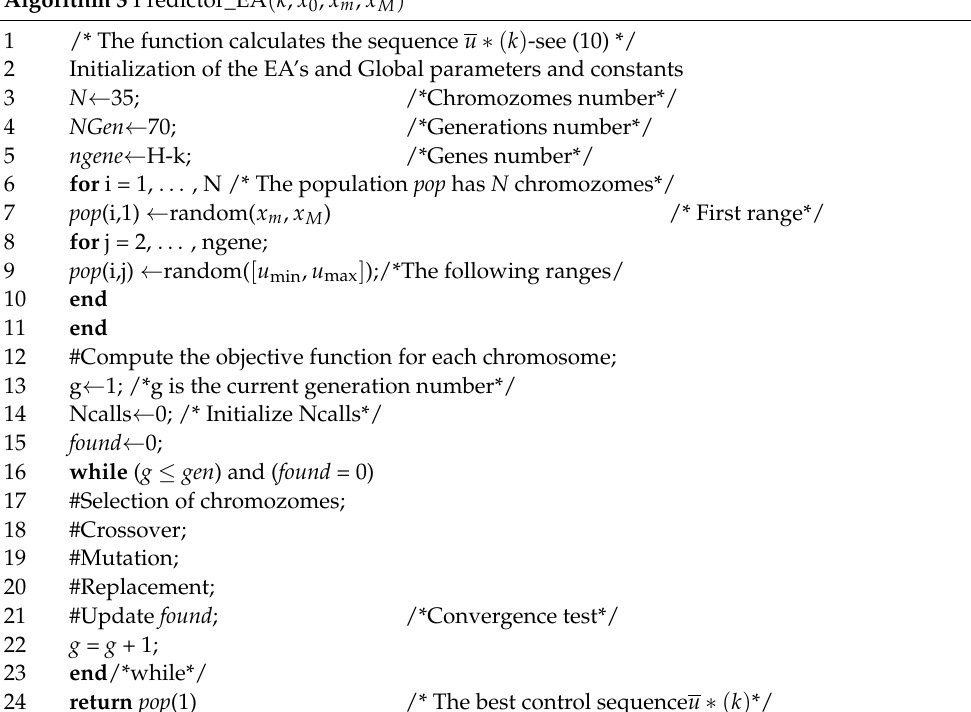
Algorithm 3 Predictor_EA ( k , x 0 , x m , x M